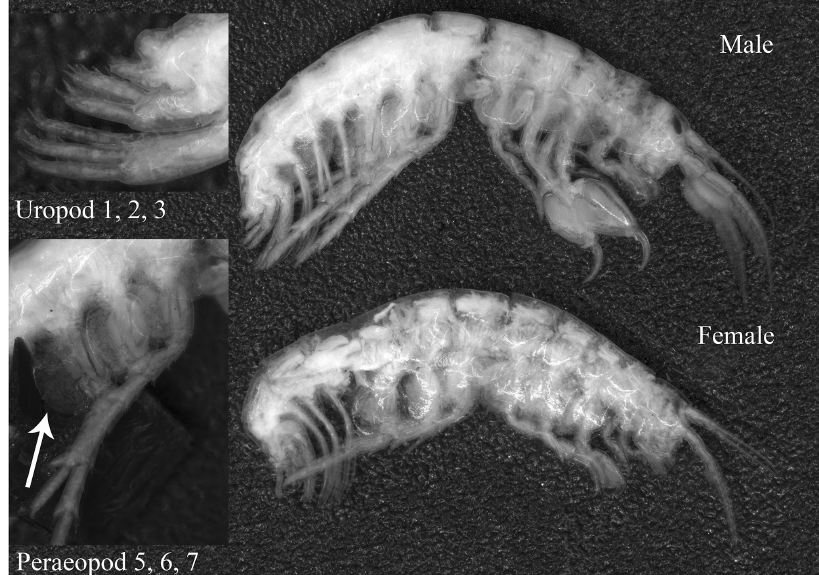
Figure 1. Male and female paratypes of Parhyale explorator (subsequently synonymised Ptilohyale explora- tor ) from Ruffo’s collection (Museum of Natural History of Verona, Italy), entire samples; male peraeo- pods and uropods, with focus (arrow) on basipodite of peraeopod Table 2. Diagnostic character states observed in the Ptilohyale explorator ( species inquirenda ) paratypes stored at the Museum of Natural History of Verona (Italy) and the Natural History Museum of Paris (France), and in the Ptilohyale littoralis sampled in the Bay of Arcachon (France); compared with Arresti’s description of Ptilohyale explorator and Bousfield and Hendricks’s Ptilohyale littoralis description. The table shows the incon- gruences (*) between the description of Ptilohyale exploratory by Arresti and the deposited paratypes.